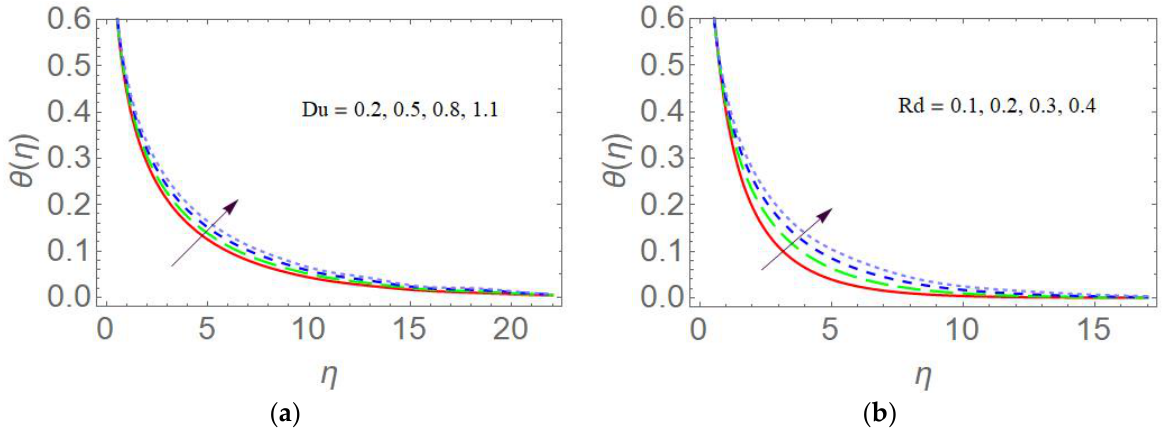
and ( b ) Radiation parameter Rd on 𝜃𝜃 ( 𝜂𝜂 )